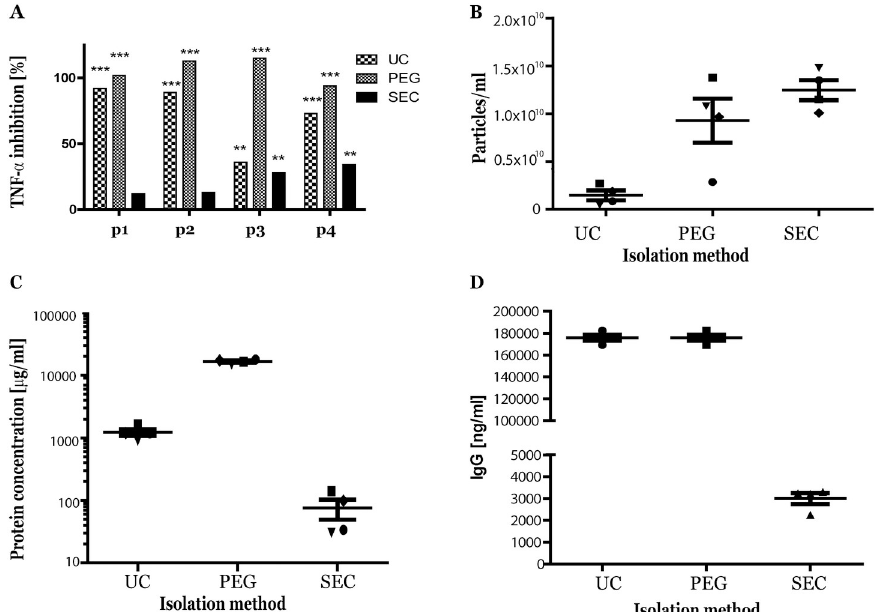
Fig 1. Presence of etanercept in pEV samples isolated from RA patients. From 4 etanercept-treated RA patients pEVs were isolated by three different conventional isolation methods (UC, PEG or SEC). TNF- α inbition was determined in all obtained pEV samples using a TNF- α sensitive reporter assay (A). Next, particle and protein concentration was measured by Nanosight tracking analysis (NTA) (B) and micro-BCA protein assay (C). Own IgG levels in pEV samples were measured by ELISA (D). Statistically significant TNF- α reduction versus control (only TNF- α without pEVs) was determined by Mann-Whitney test, �� p < 0.01, ��� p < 0.001.